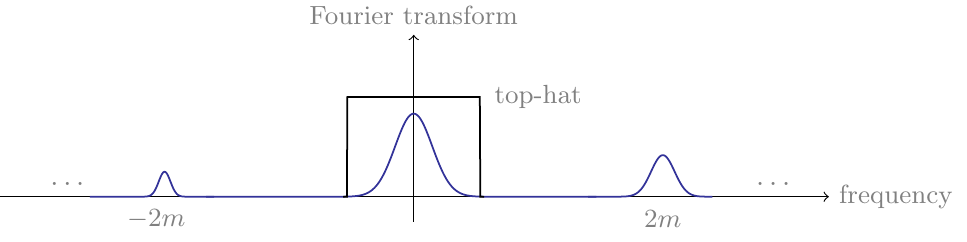
Figure 2 . Typical frequency spectrum of the variables in the problem. The system is dominated by the slowly varying mode, though modes associated with rapid oscillations also arise in the